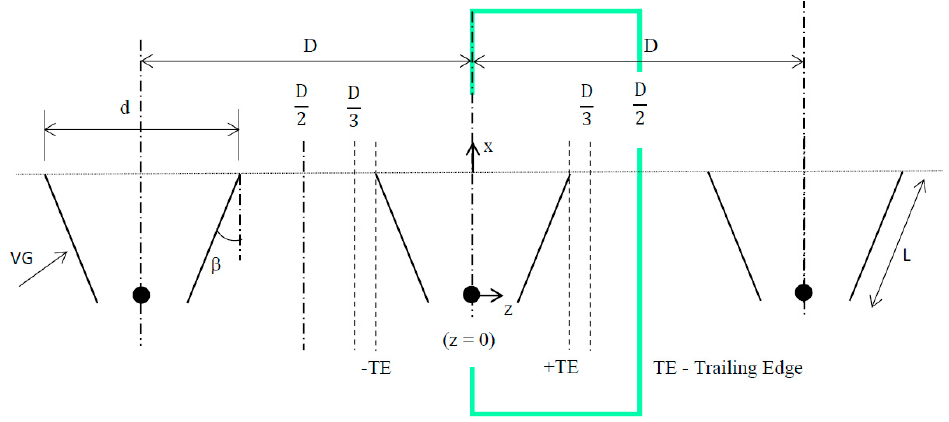
Figure 2. Vortex generator array layout.